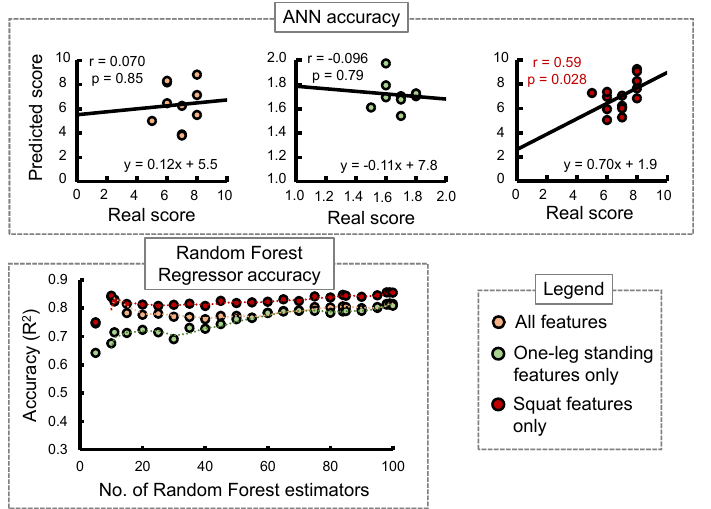
Figure 7. Comparing the accuracy of the ANN and Random Forest regressor in predicting the STBLS test stand-up